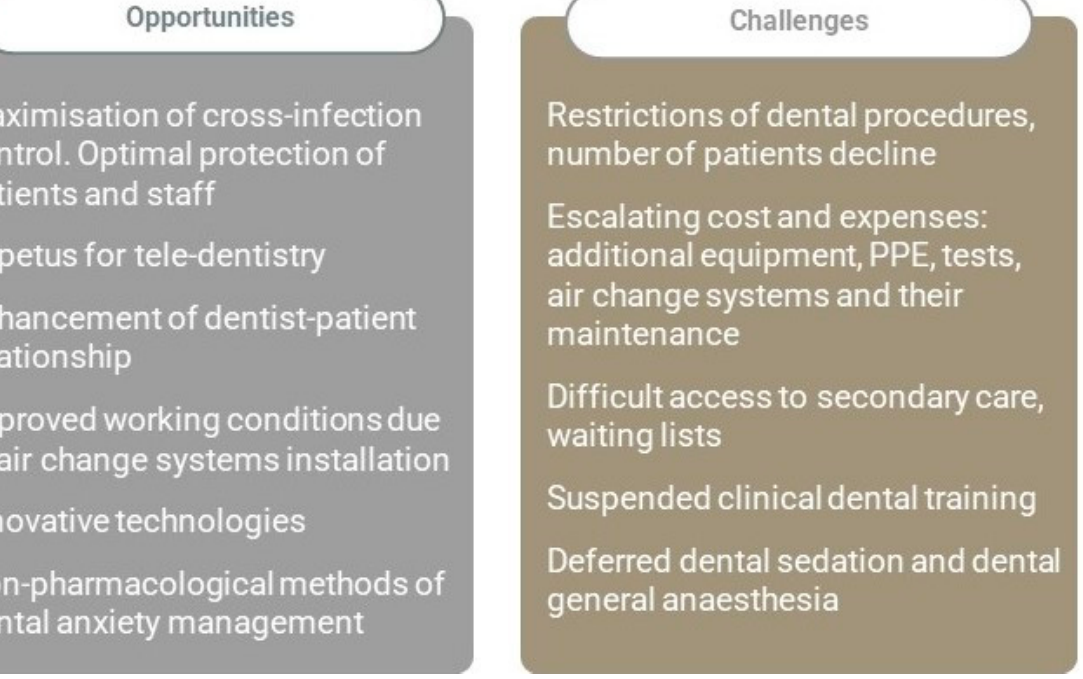
Figure 1. The impact of COVID-19 on the dental care sector. Potential opportunities and negative consequences.